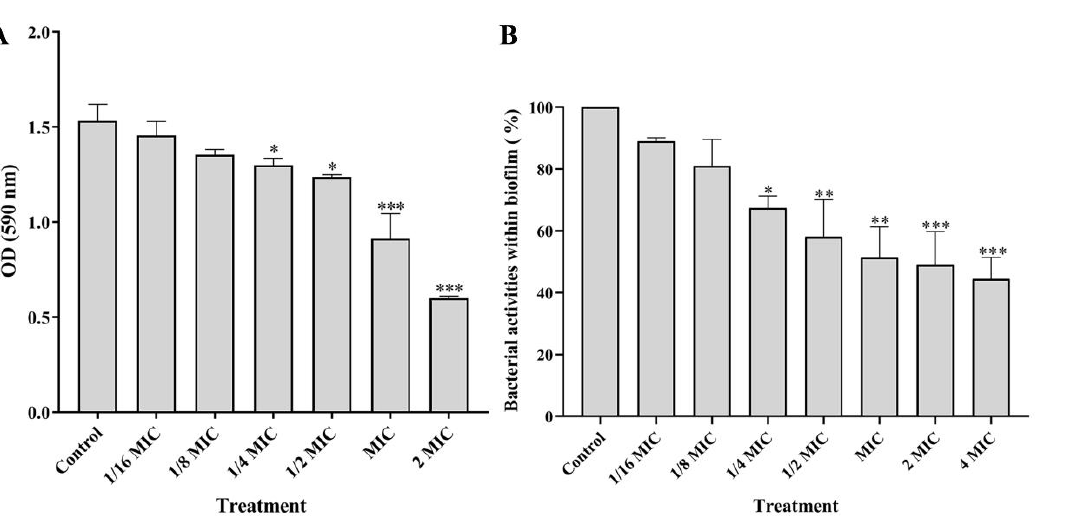
Figure 2. Effect of PEO on biofilm of S. mutans . ( A ) PEO suppresses the total biofilm biomasses with the increase of concentration (* p < 0.05, ** p < 0.01, *** p < 0.001). ( B ) PEO decreases the bacterial activities within biofilm with the increase of concentrations. ( C ) Representative fluorescent images